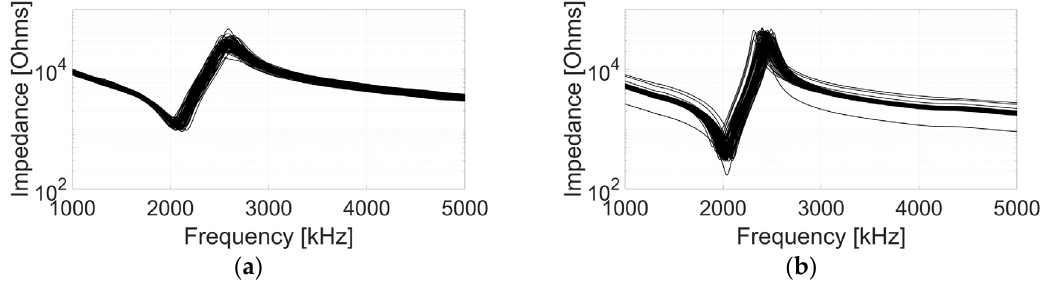
Figure 6. Impedance response of all array elements for ( a ) the CECAT and ( b ) the C1–3. Three transducer parameters—the resonance frequency ( 𝑓 (cid:3045) ), the anti-resonance frequency ( 𝑓 (cid:3028) ) and the coupling coefficient ( 𝑘 (cid:3047) )—are used to evaluate the piezoelectric performance of the active layers and the individual array elements [28]. The averaged values for each parameter are listed in Table 3. As shown in the table, the CECAT and the C1–3 have similar 𝑓 (cid:3045) , while the CECAT has higher 𝑓 (cid:3028) than the C1–3. This situation is associated with the better performance of the CECAT in terms of 𝑘 (cid:3047) (0.64 to 0.59). The standard deviation results shown in Table 3 indicate that the CECAT has better uniformity in terms of 𝑓 (cid:3045) and 𝑓 (cid:3028) , while the array elements in the C1–3 perform better in terms of 𝑘 (cid:3047) . Table 3. Analysed parameters for both active layers.